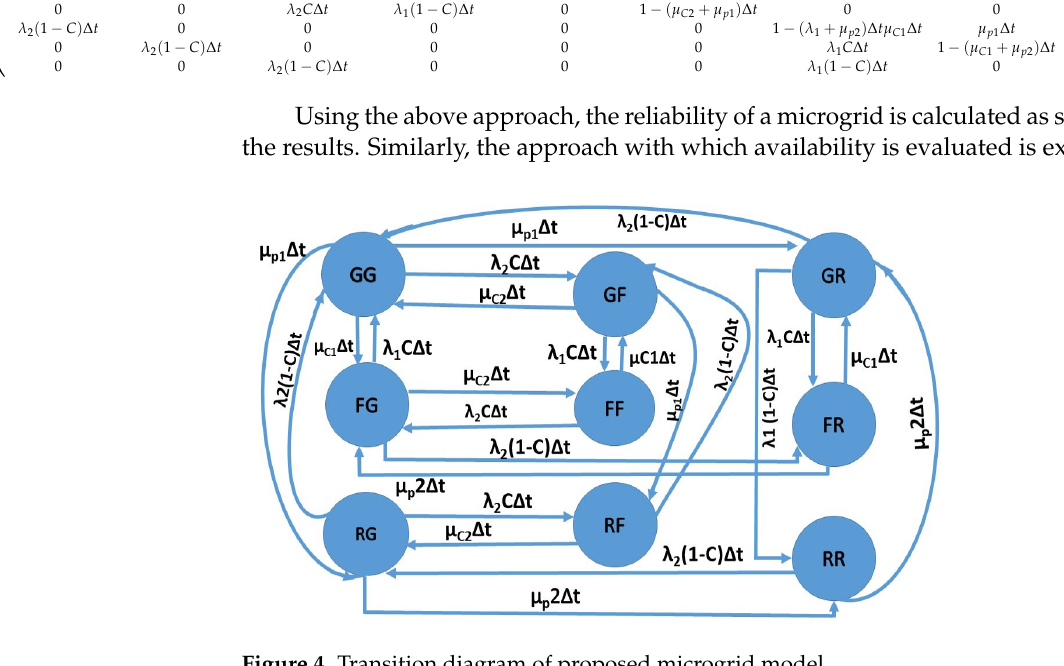
Figure 4. Transition diagram of proposed microgrid